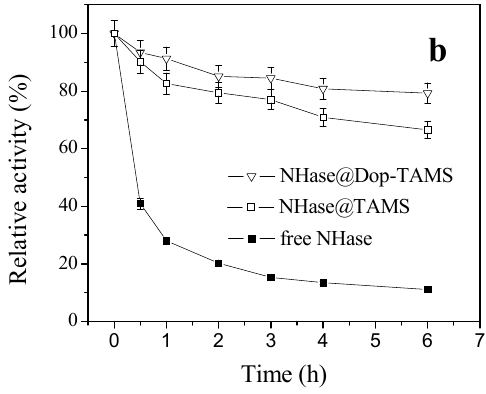
Figure 6. pH stability of free NHase and immobilized NHase at ( a ) pH 3.0; and ( b ) pH 9.0.